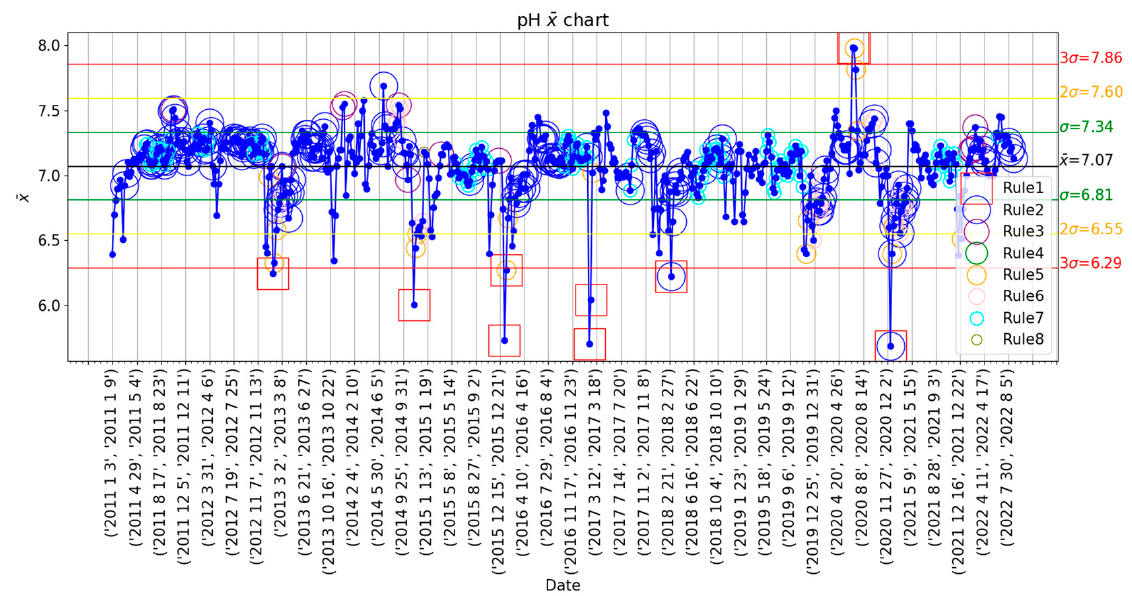
Figure 2. pH data represented in the 𝑥̅ control chart with weekly rational subgroups and the 8 Nelson rules implemented for outlier detection, trend study, and variability analysis. The mean of all subgroups is represented by a black line, while the green, yellow, and red lines mark the ± 1 σ , ± 2 σ , and ± 3 σ limits, respectively.